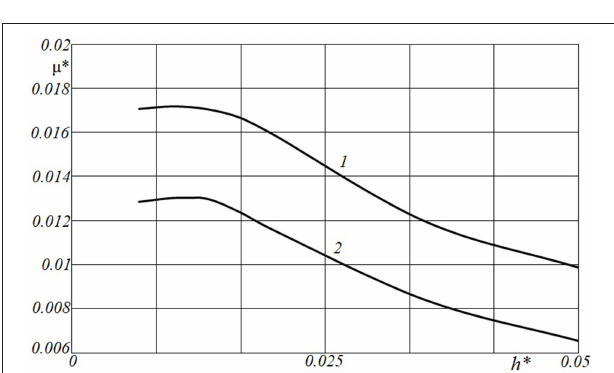
FIGURE 13 | Dependence of friction coefficient on layer thickness. [ c = 6; ν = 0.4; Q ′ = 2.0; V ∗ = 0.05(curve 1); V ∗ = 0.2 (curve 2)].